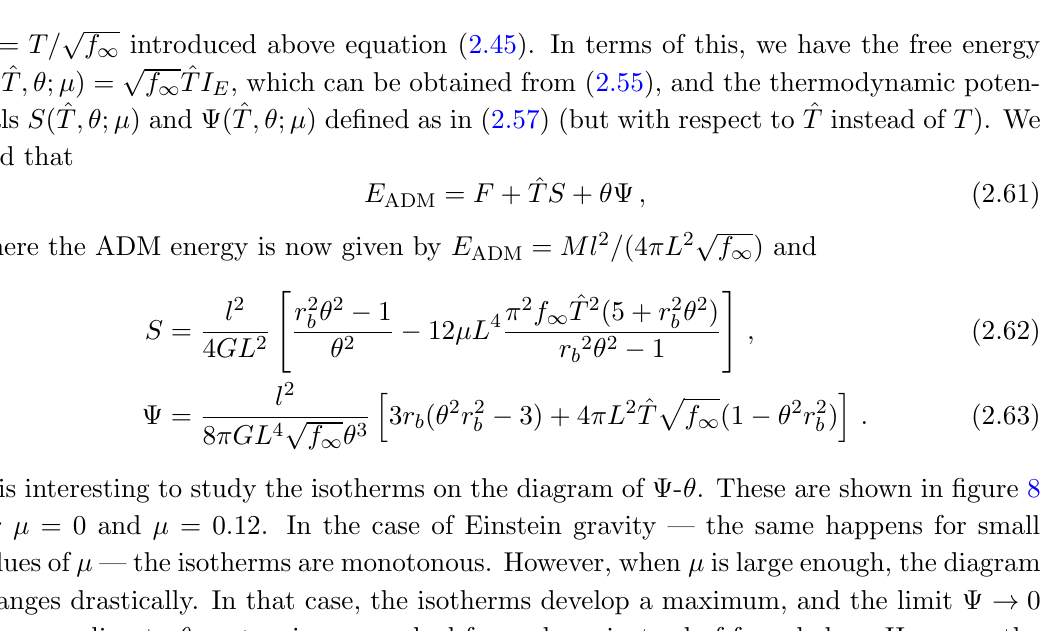
Figure 8 . Isotherms in the (cid:9)- (cid:18) plane. Left: (cid:22) = 0. Right: (cid:22) = 0 :